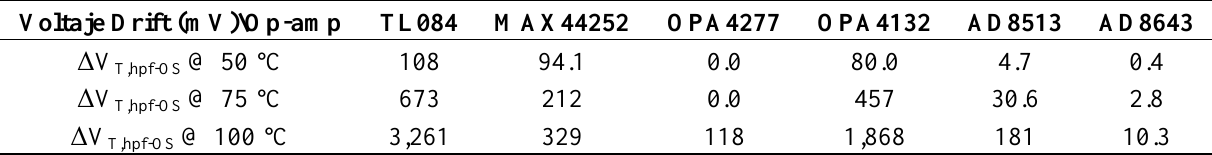
Table 12. Output voltage drifts ΔV 25 °C point of